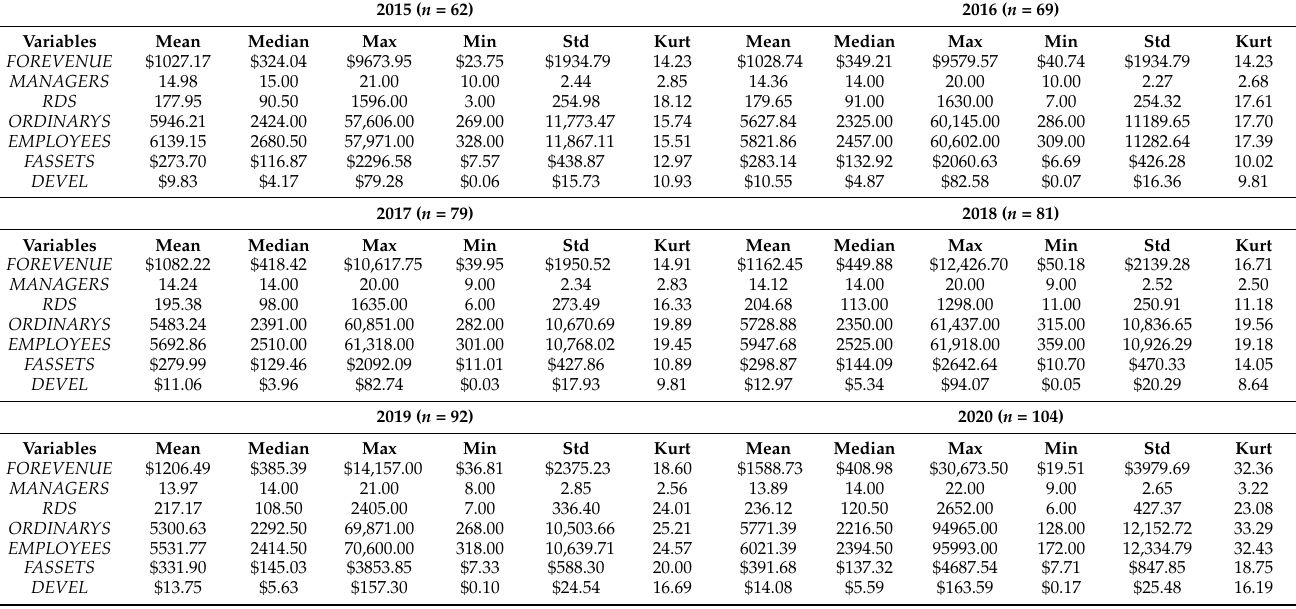
Table 2. Changes in variables from 2015 to